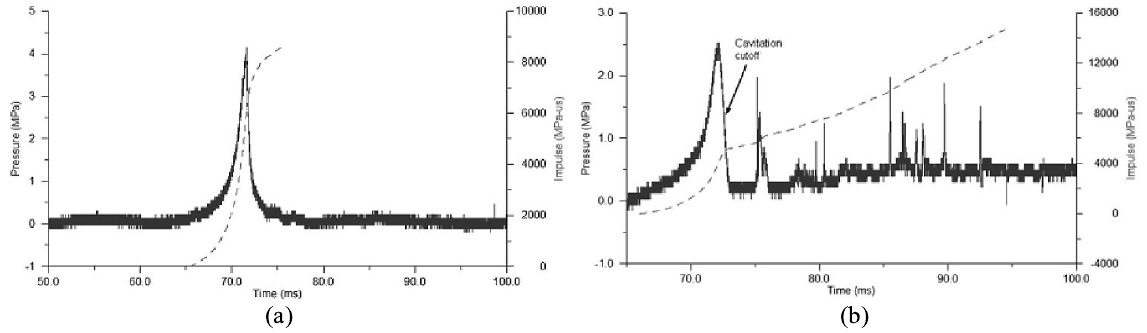
Fig. 3. Bubble collapse pressure histories: a) free-field, b) on plate surface. Dashed lines represent